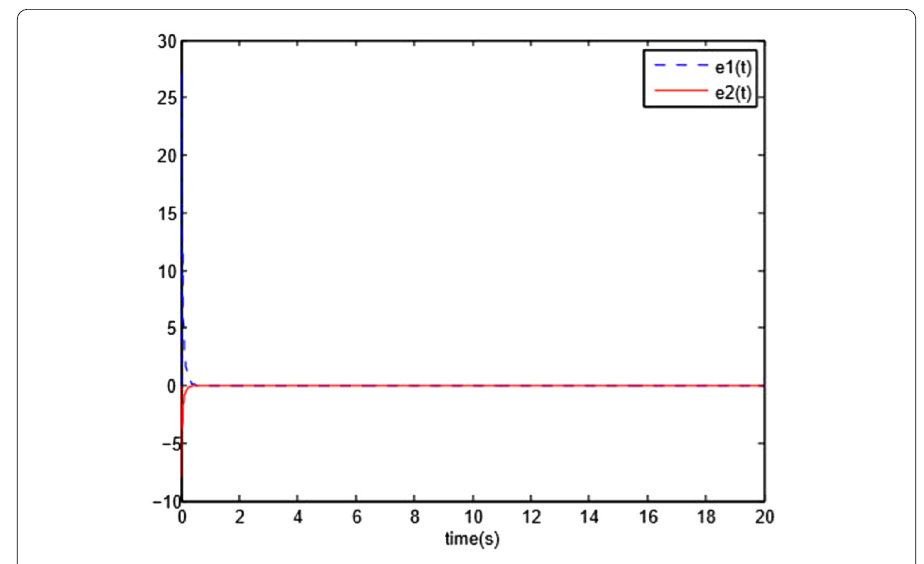
Figure 3 Dynamics of states e 1 ( t ) and e 2 ( t